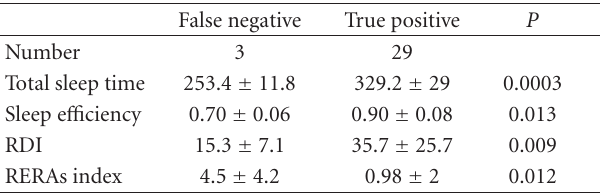
Table 4: Characteristics of false negative patients. False negative True positive